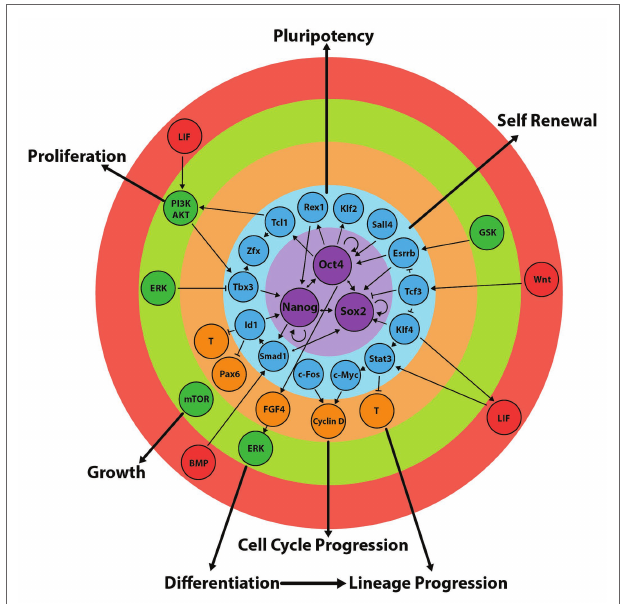
FIGURE 6 | Regulation of the core and extended pluripotency networks in mouse embryonic stem cells. Maintenance of pluripotency and self-renewal is governed by external stimuli (red), which act on various signalling pathways (green) that regulate the expression of the extended (blue) and core (purple) pluripotency networks. In turn, the expression of transcription factors of the core circuitry regulates their own expression, as well as the expression of other factors involved in differentiation and/or self-renewal (orange). Figure adapted from data published in: (Jirmanova et al.,